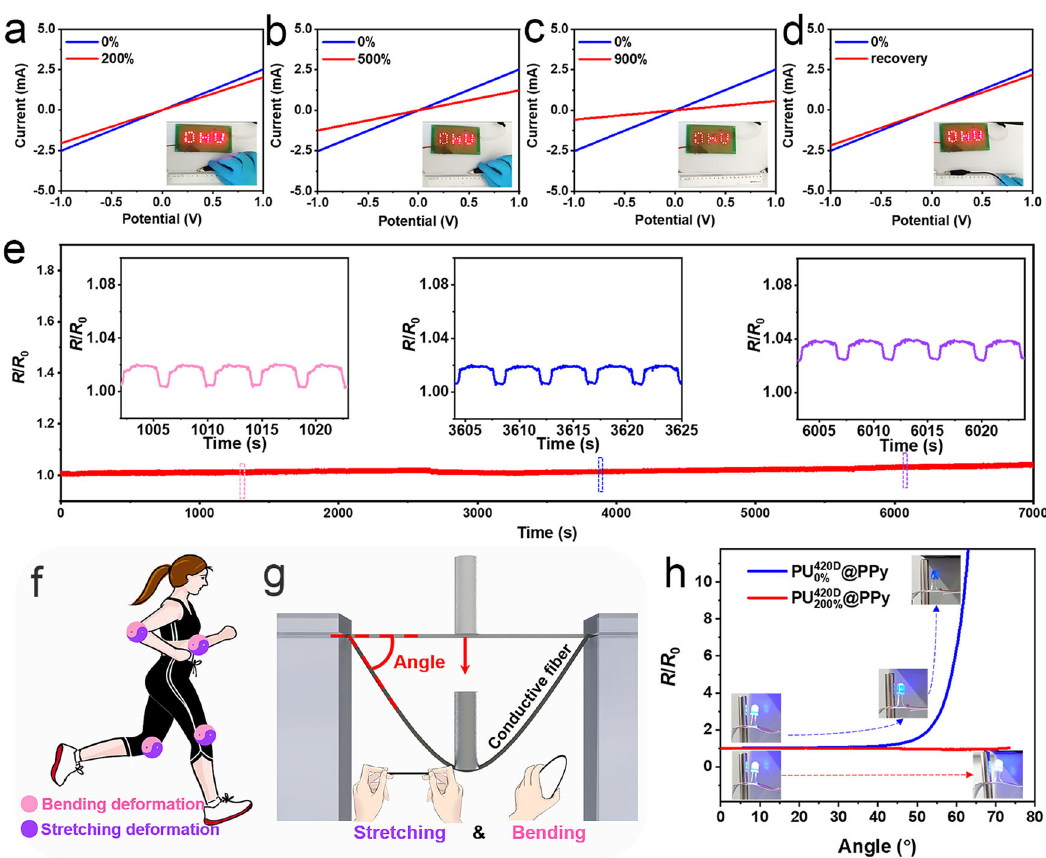
Fig. 5 Conductivity stability of the PU 420D @PPy. a – d The I - V curves of PU 420D @PPy at different strains (200%, 500%, 900%, and recovery). 200% 200 % e The 1500 cyclic loading-unloading test of PU 420D @PPy under 20% strain. Inset shows 5 cycles at the beginning and the end of the 1500 200 % cycles, respectively. f Schematics for dual bending (pink) and stretching (purple) deformation for human body movement. g Stretching- bending instrument for the fi lament. h Real-time resistance change of the fi lament during a stretching-bending